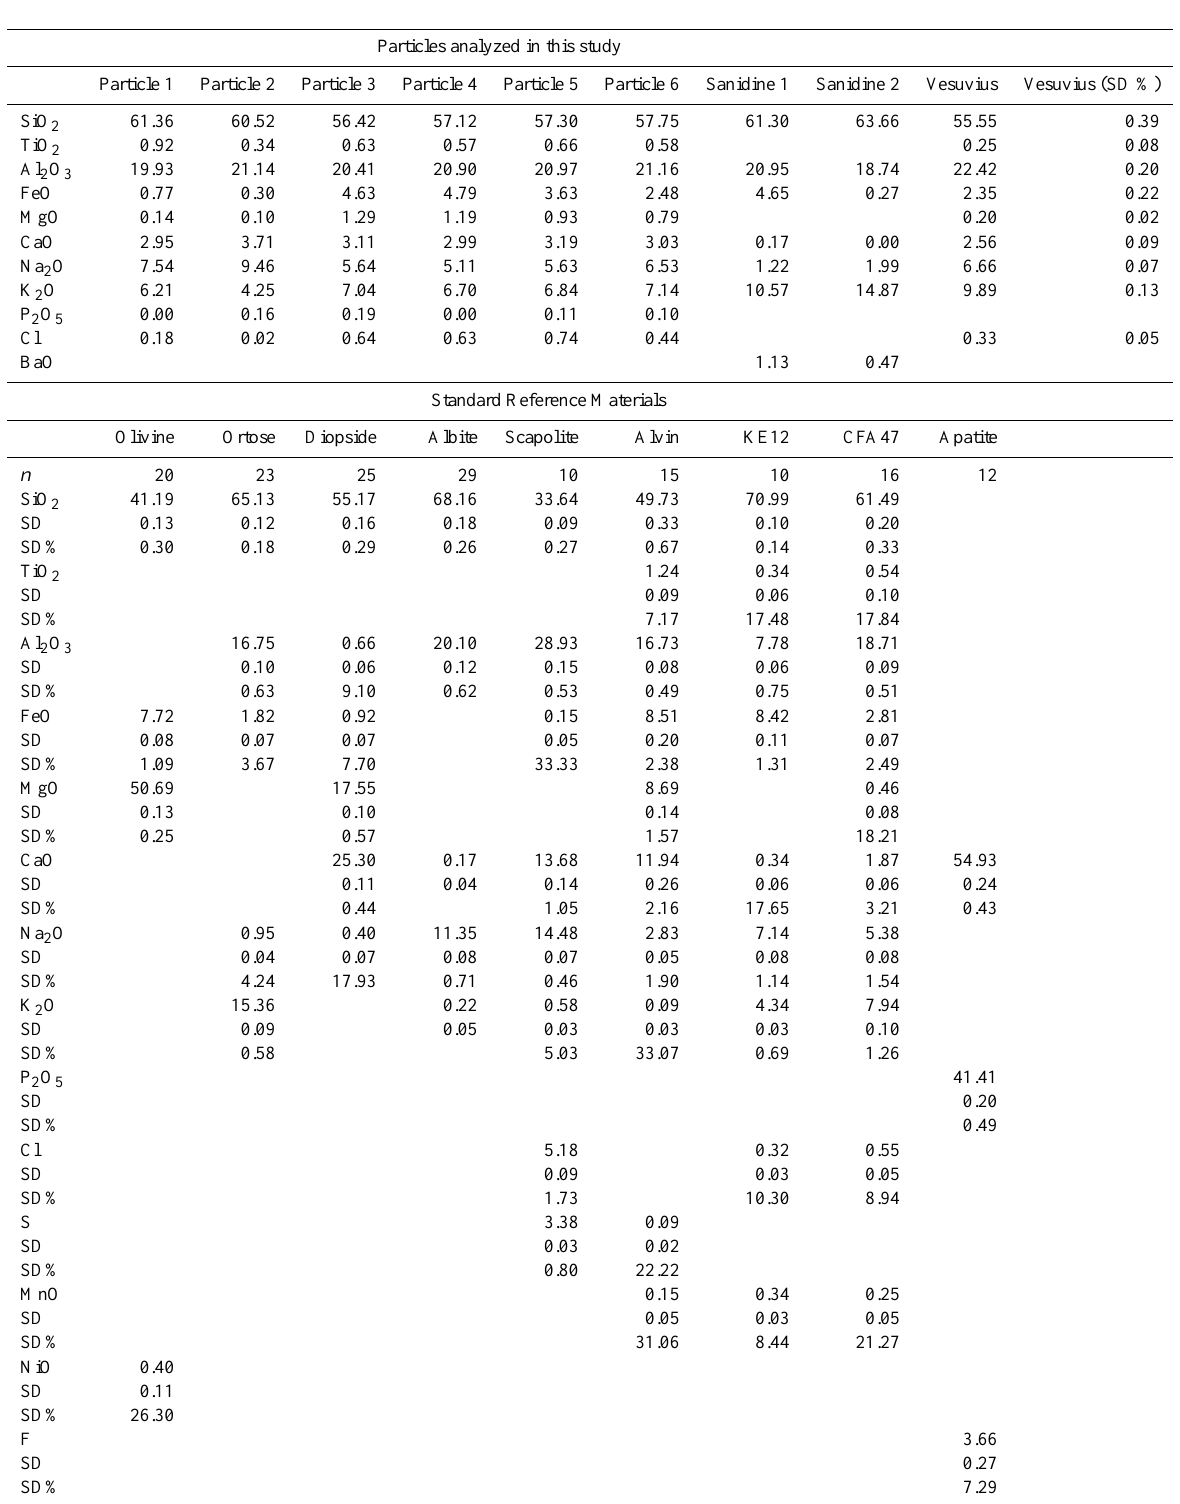
Table 1. Concentrations (wt%) of major oxides and Cl in the six micrometer-sized volcanic glass particles and two sanidine fragments found at a depth of 429.3m in the GRIP ice core. Mean and standard deviations from 10 K-phonolitic volcanic glasses from the 79AD eruption (data from Balcone-Boissard et al., 2009). Totals have been normalized to 100%. The standard reference materials are included, where n is the number of times these reference materials were